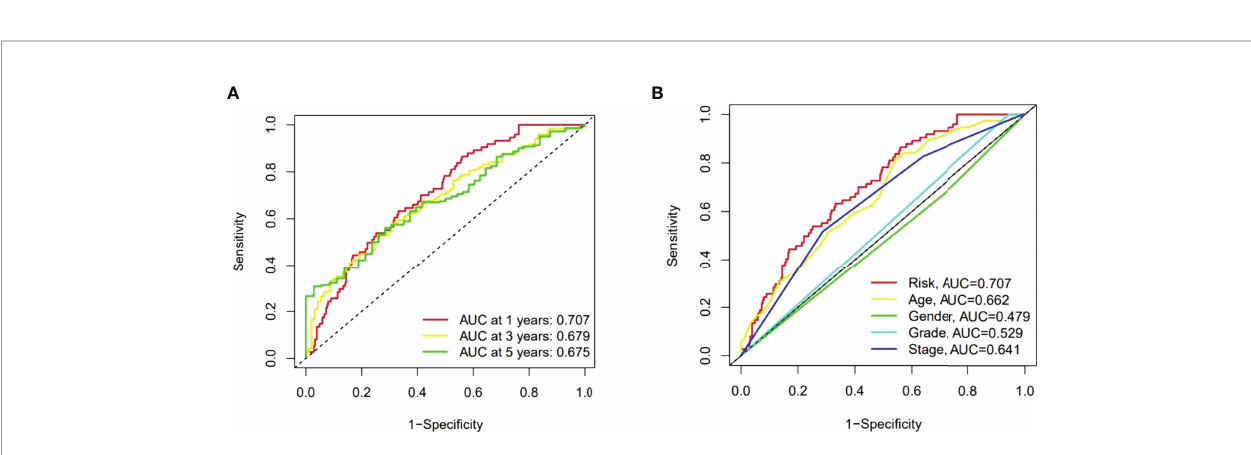
FIGURE 6 | The 1-, 3-, and 5-year ROC curves of the whole group (A) . The 5-year ROC curves of the risk score and clinical factors (B)